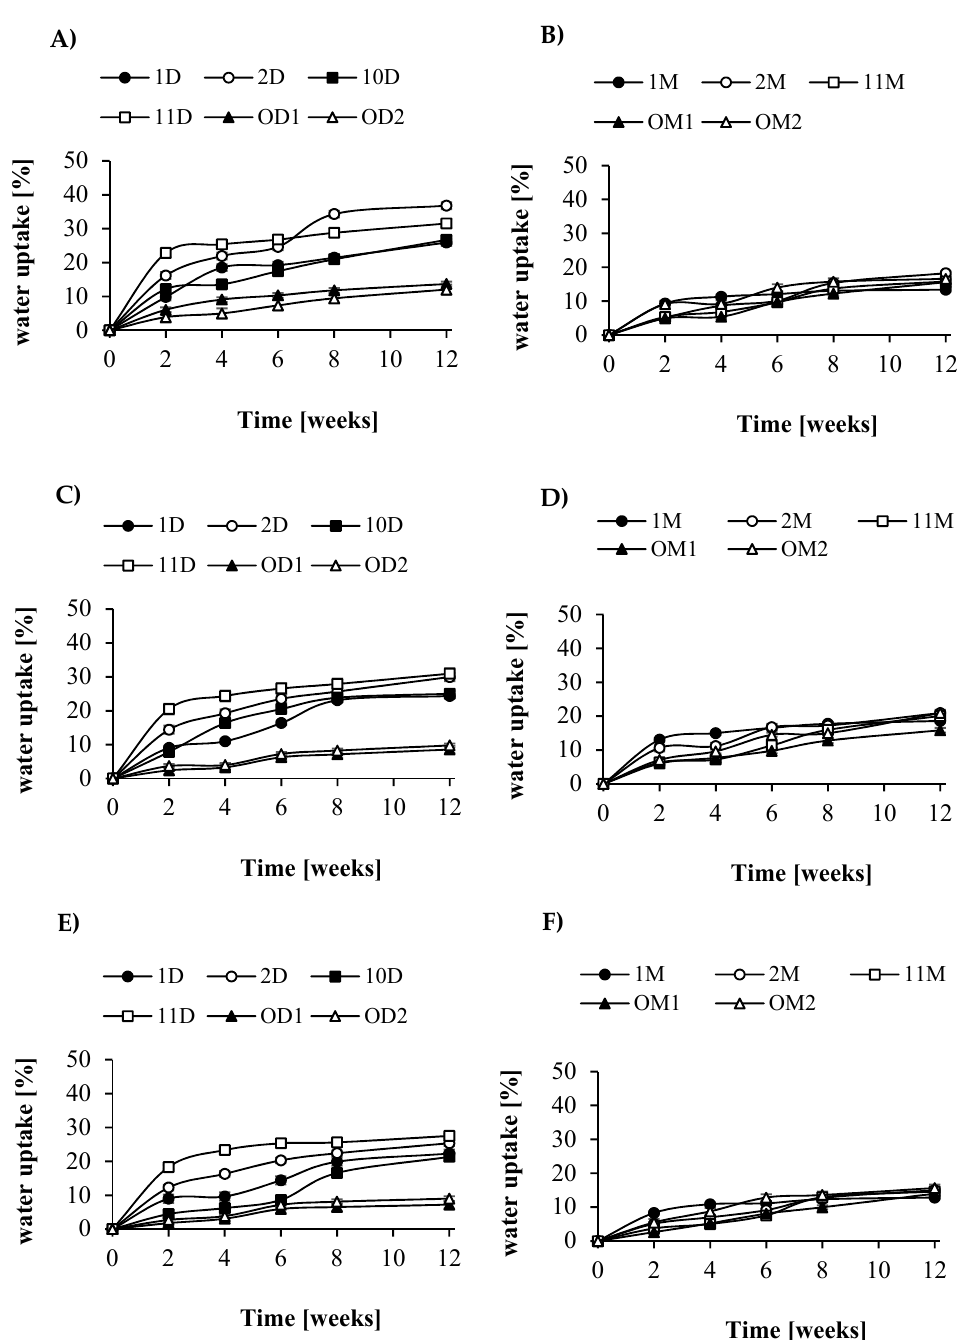
Figure 4. Water uptake of the samples: ( A )—LA / GA / PEG + dextrin in water, and ( B )—LA / GA / PEG + maltodextrin in water; ( C )—LA / GA / PEG + dextrin in soil, and ( D )—LA / GA / PEG + maltodextrin in soil; ( E )—LA / GA / PEG + dextrin in activated sludge and ( F )—LA / GA / PEG + maltodextrin in activated sludge.